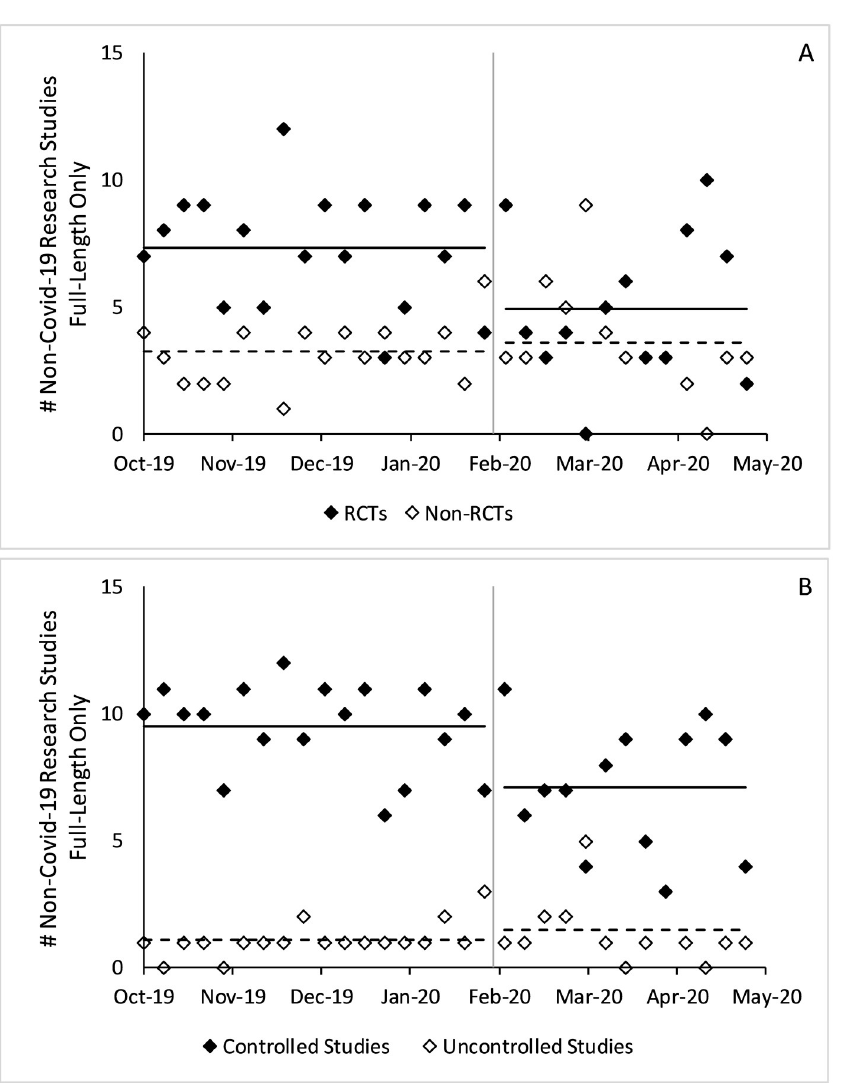
Fig 3. Changes in full-length non-Covid-19 research studies published before and after Covid-19. Figure includes all non-Covid-19 full-length research studies in counts per week. A) controlled versus uncontrolled studies B) RCTs versus non-RCTs. P-values estimated using a two-sample t-test. The gray vertical lines denote January 31, 2020, the boundary between the pre- and post-Covid-19 eras. Solid horizontal lines denote average values of the solid dots and dashed horizontal lines denote average values of the hollow